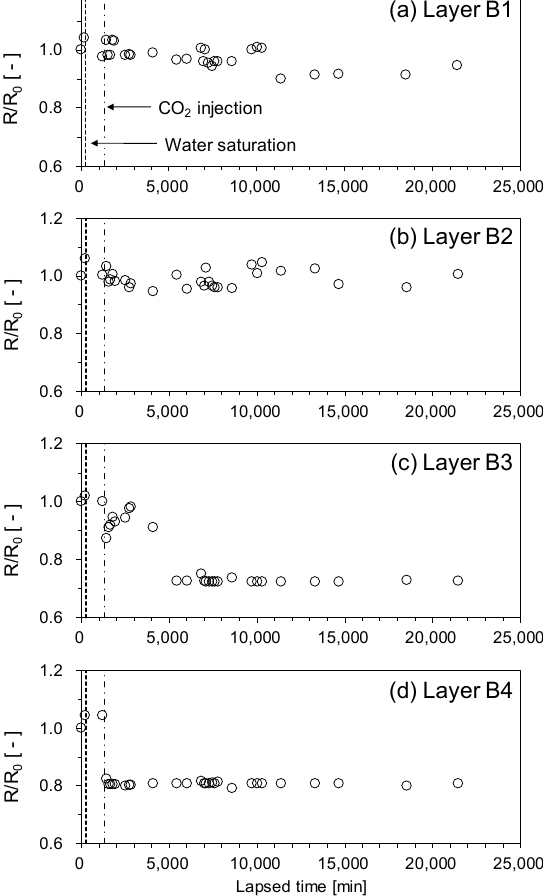
Figure 7. Normalized electrical resistance R / R 0 of the unconsolidated sediment sample during CO 2 injection. ( a ) layer B1, ( b ) layer B2, ( c ) layer B3, ( d ) layer B4.